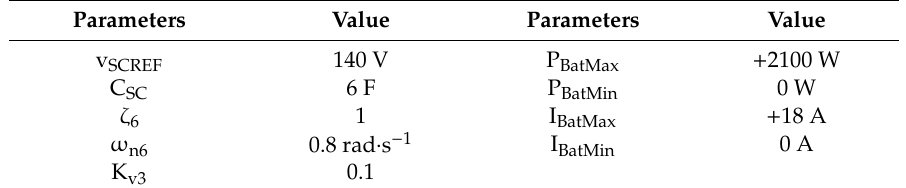
Table 4. Total energy regulation parameters.